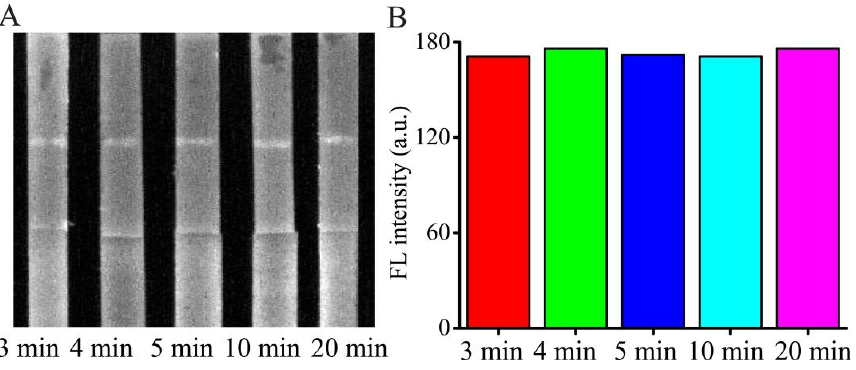
Figure 4. Optimization of the detection time. (A) Image of AMP detection time. (B) FL intensity of different detection time at T line.